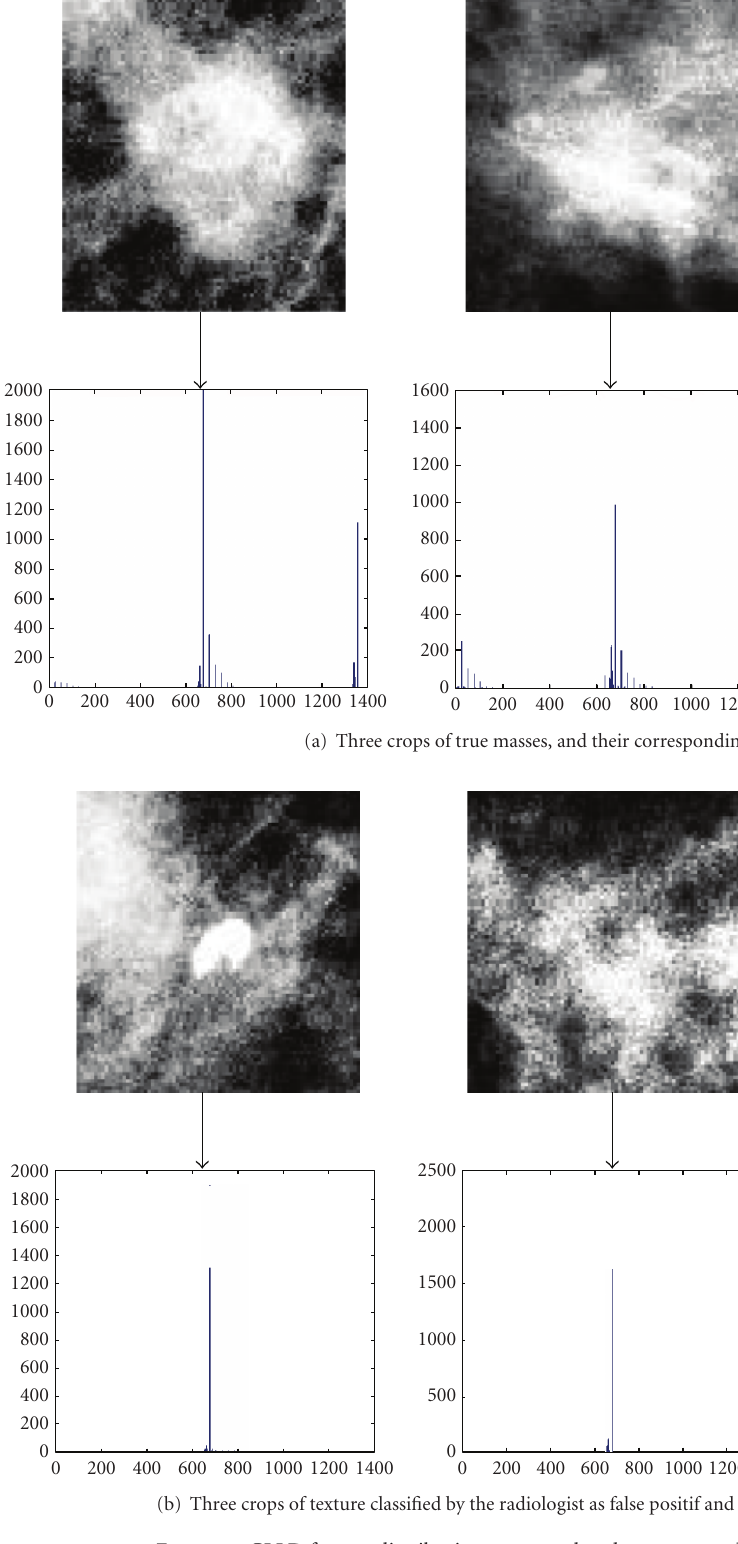
Figure 7: GLLD feature distributions extracted and concatenated to constitute the final